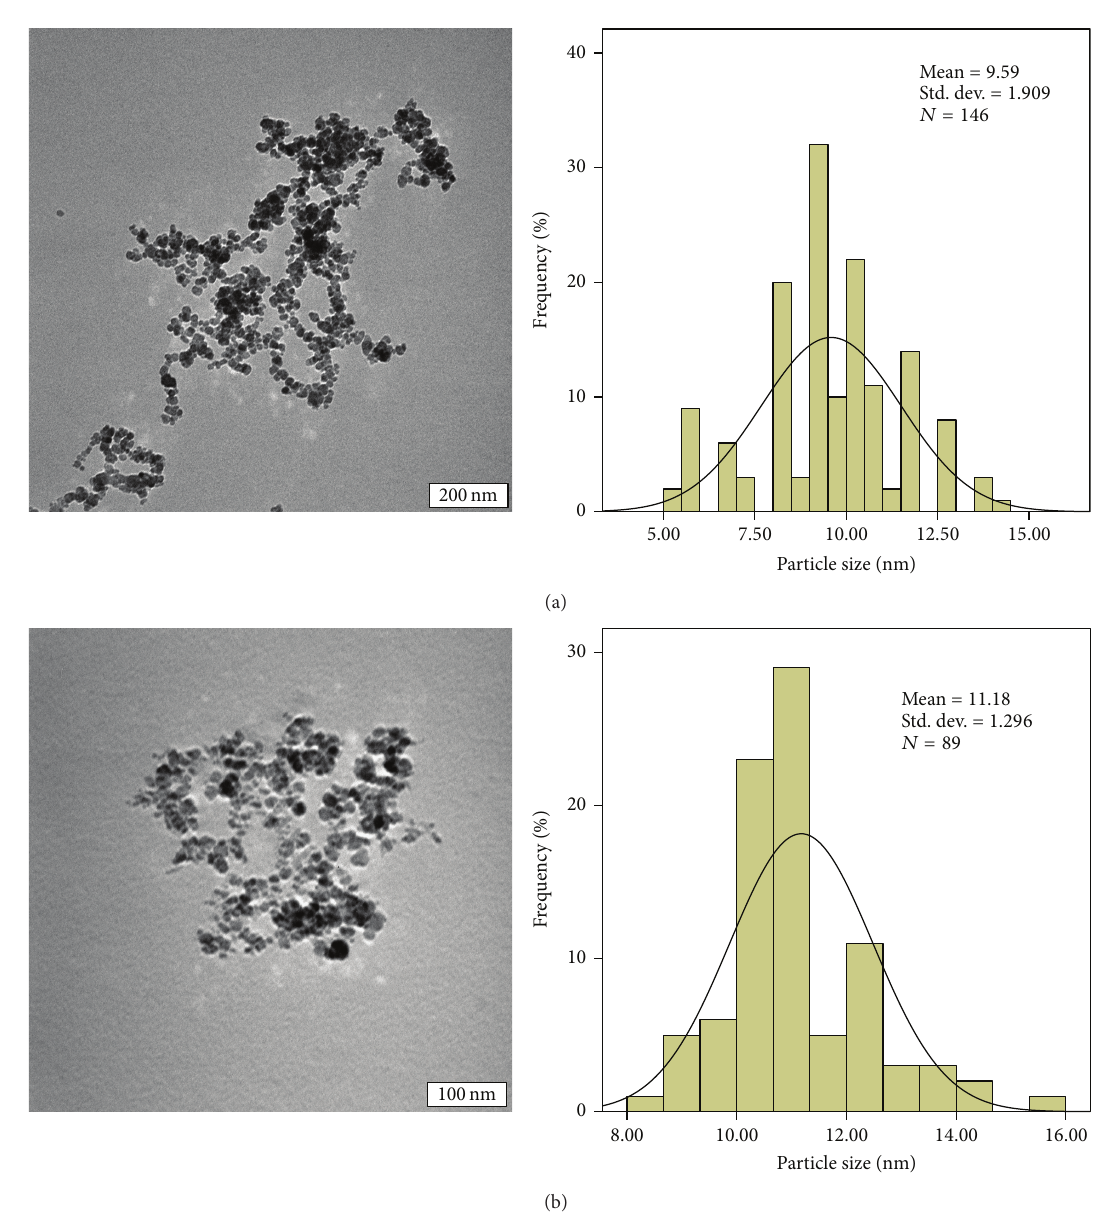
Figure5:TEMmicrographsof(a)ironoxidemagnetitenanoparticleswith200 nmmicrobarandtheparticlesizedistribution,(b)FPEGMP-2 nanocomposite with 100nm microbar and the particle size